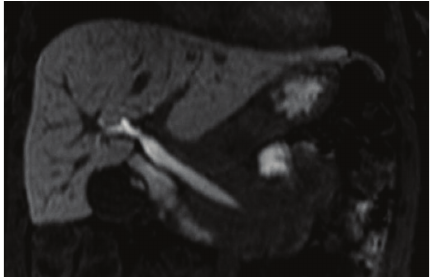
Figure 5: Coronal multiplanar reformation Gd-EOB-DTPA enhanced T1 weighted 3D GRE image obtained 30 minutes after injection shows contrast material in bile duct and duodenal lumen. Not inside the cyst.